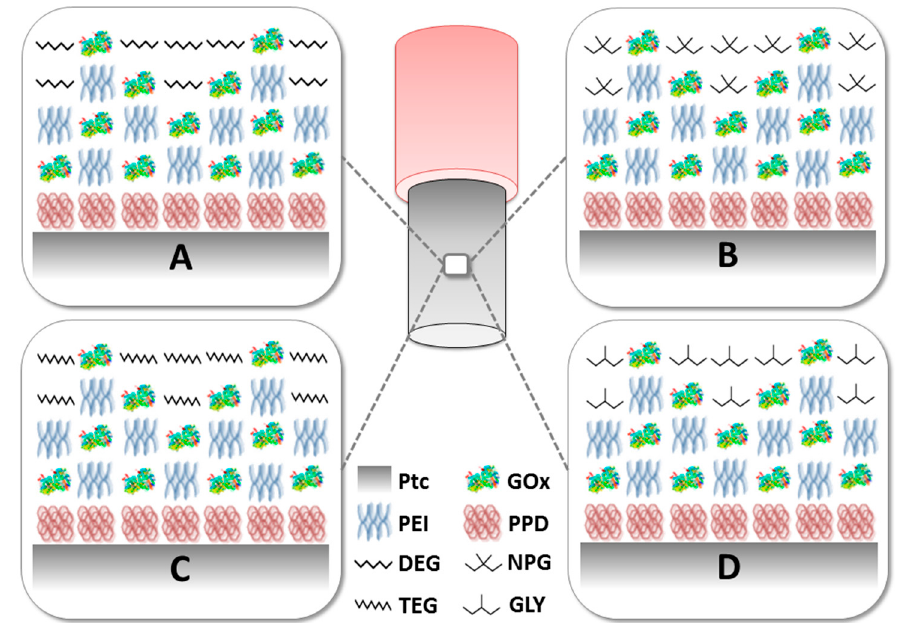
Figure 1. Schematic representation of the glutamate biosensors described in this study Panel A : Pt c / PPD / PEI(1%) 2 / GlutOx 5 / DEG(0.1%); Panel B : Pt c / PPD / PEI(1%) 2 / GlutOx 5 / NPG(0.1%); Panel C : Pt c / PPD / PEI(1%) 2 / GlutOx 5 / TEG(0.1%); Panel D : Pt c / PPD / PEI(1%) 2 / GlutOx 5 / GLY(0.1%). Pt c : Pt cylinder 1 mm long; GlutOx: L-glutamate oxidase; PPD: ortho-phenylenediamine polymer; PEI: polyethyleneimine, DEG: diethylene glycol, NPG: neopentyl glycol, TEG: triethylen glycol, GLY: glycerol, PG: propylene glycol. The subscript number represents the number of dips and in brackets, the concentration of the glycol.